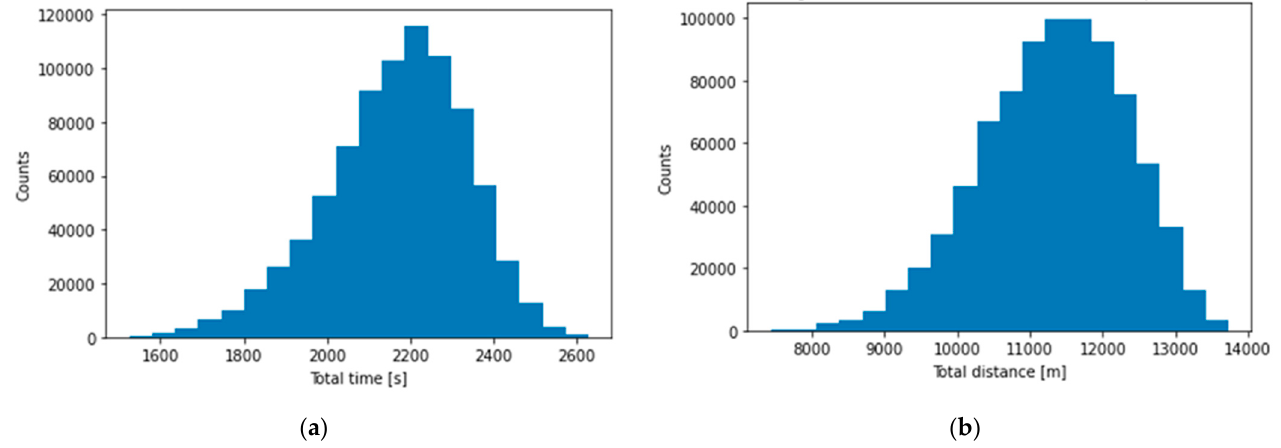
Figure 2. Histograms for all Bin Pack routes according to ( a ) time and ( b ) distance. All TSP-optimal routes for all knapsacks have a mean time of 2780 s, maximum spread is 855 s and standard deviation of population is 164 s.